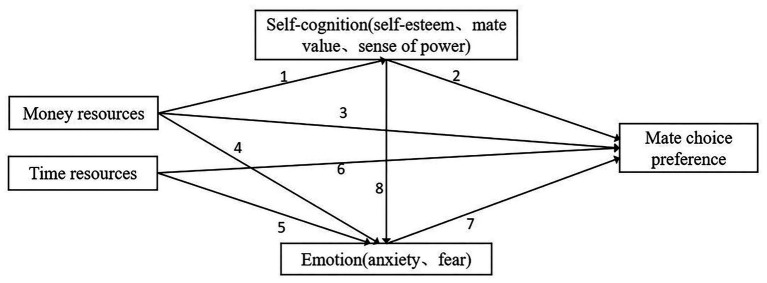
Path diagram of resource influence on mate choice preference.